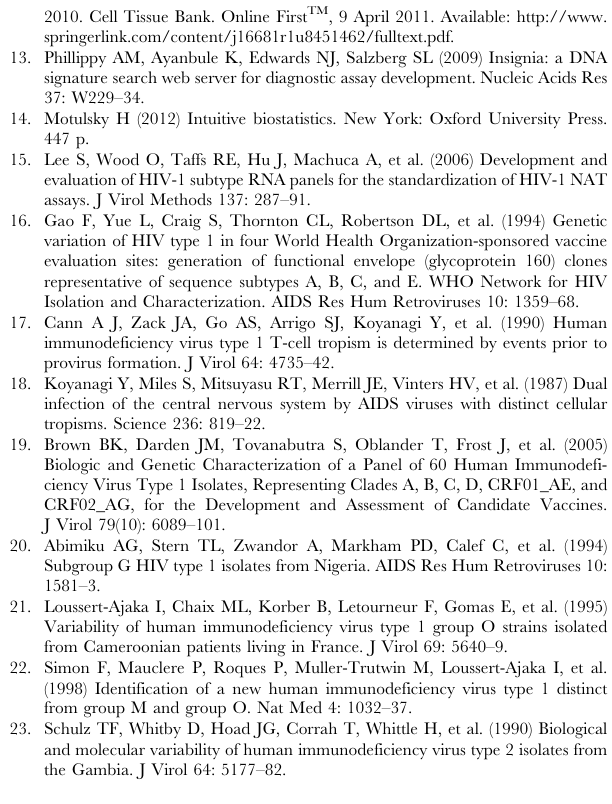
Table S1 List of the synthetic templates used as analytical standards in real-time PCR assay. Table S2 Intra and inter-assay reproducibility of viral quantification evaluated using analytical DNA or RNA standards for each virus specific primer set selected for the real-time PCR